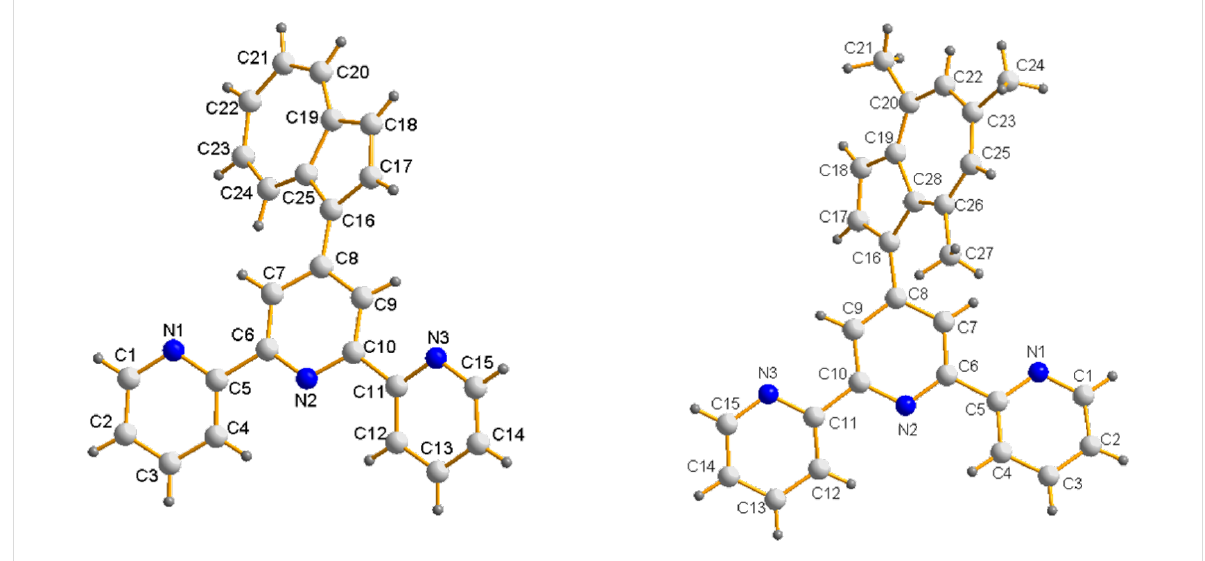
Figure 1: Molecular structure and numbering scheme of 4 ′ -(1-azulenyl)-2,2 ′ :6 ′ ,2 ″ -terpyridine ( 4a , left) and 4 ′ -(1-(4,6,8-trimethyl-azulenyl)-2,2 ′ :6 ′ ,2 ″ - terpyridine ( 4b , right).